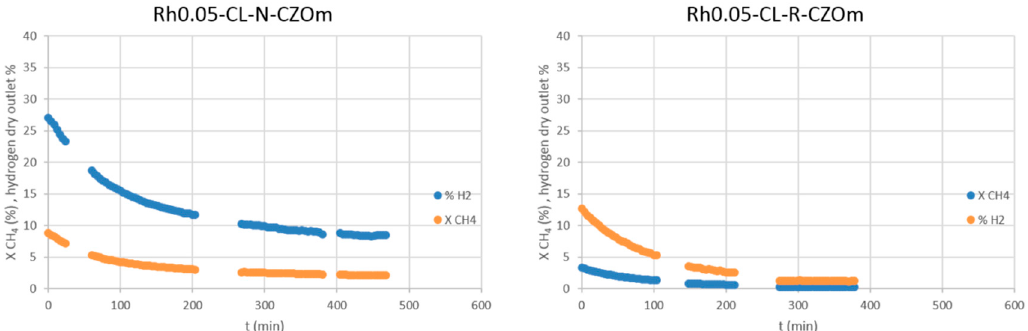
Figure 17. Methane conversion and hydrogen dry outlet percentage obtained on